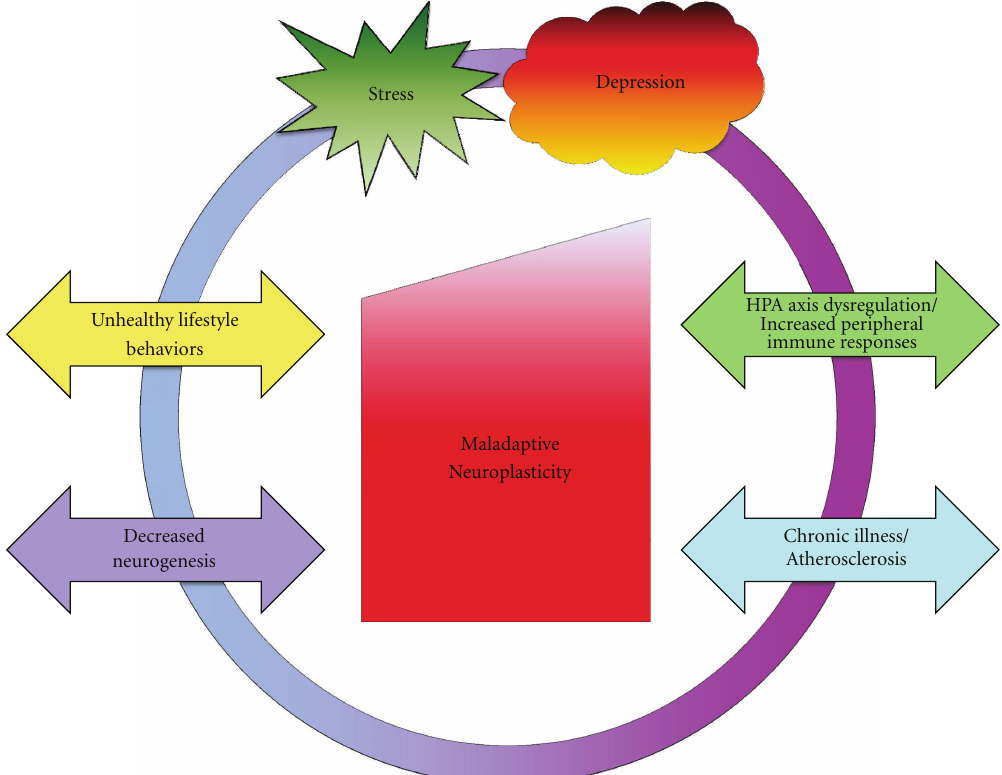
Figure 1: The Cycle of Maladaptive